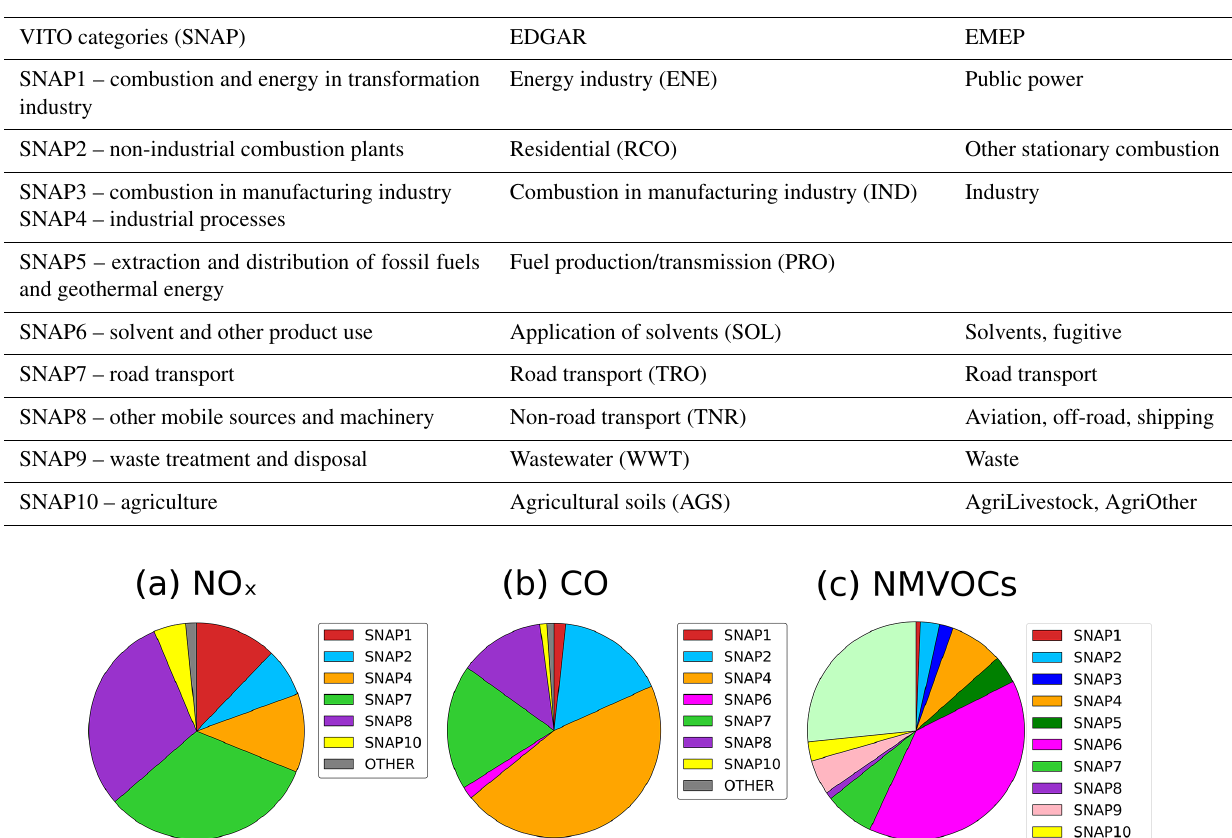
Table 2. Correspondence between the emission sectors of the SNAP, EDGAR, and EMEP inventories, as adopted in this work. VITO categories (SNAP)